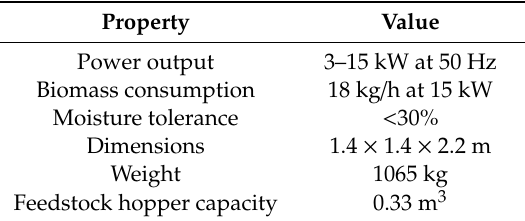
Figure 1. Pilot-scale downdraft reactor. Left: (1) Hopper, (2) Valves to flare and engine, (3) Control unit, (4) Ash vessel, (5) Gas filter, (6) Operational panel, (7) Generator, (8) Wiring box, (9) Grid-tie. Right: (1) Flare, (2) Exhaust stack, (3) Reactor access port, (4) Gasifier, (5) Air inlet check valve, (6) Cyclone, (7) Filter condensate drain bung, (8) Filter lid-locking lever, (9) drying bucket. Table 2. Power Pallet specifications [32].